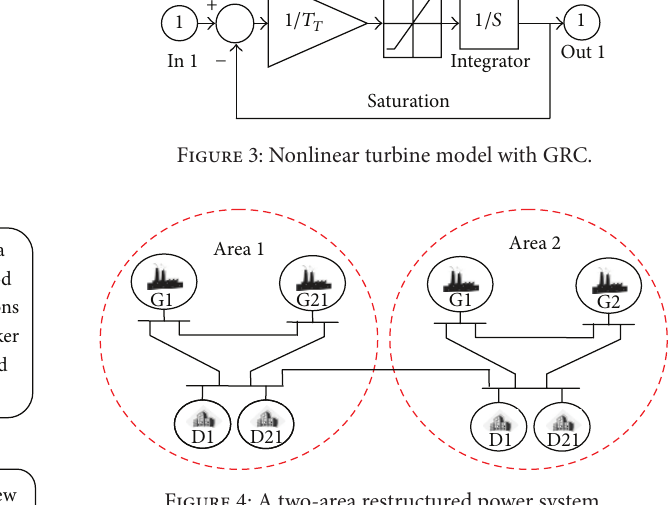
Figure 4: A two-area restructured power